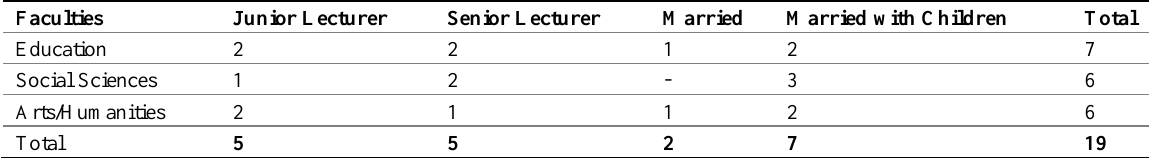
Table 1: Demographic matrix of the sample by position and family